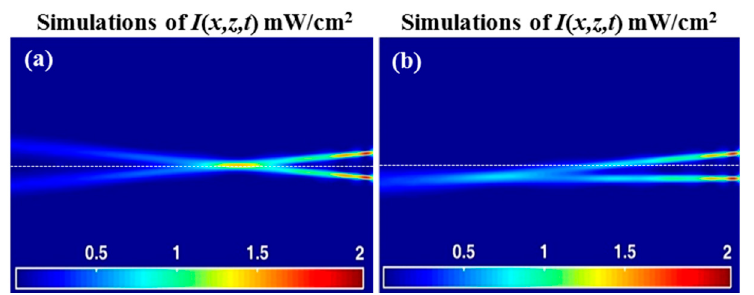
Figure 9. Predicted SWW structures, I ( x,z,t ) mW/cm 2 , formed at t exp = 1600 s of λ = 532 nm and P 0 = 0.1 mW (i.e., each fiber has P 0 = 0.1 mW) for ( a ) the X -waveguide (> 9°) and ( b ) the off-axis Y -waveguide (< 9°).